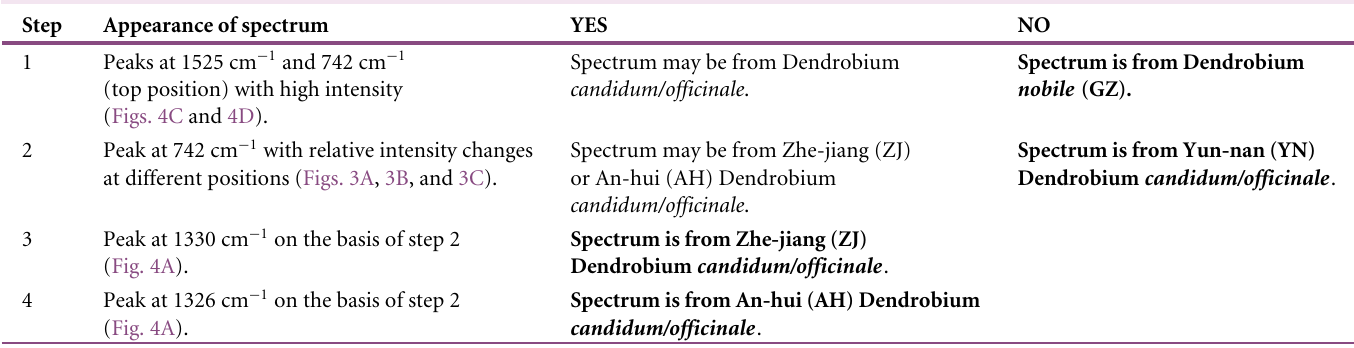
Table 3 Identification steps of Dendrobiums from different regions. Step Appearance of